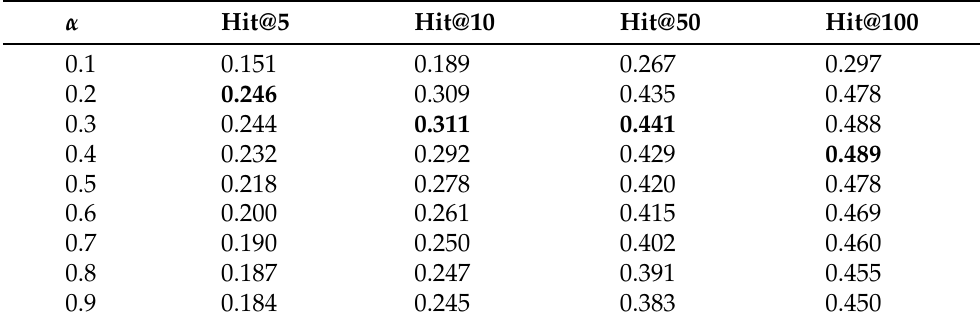
Table 5. Prediction accuracy of CWS model with different α settings; the best results are shown in boldface.